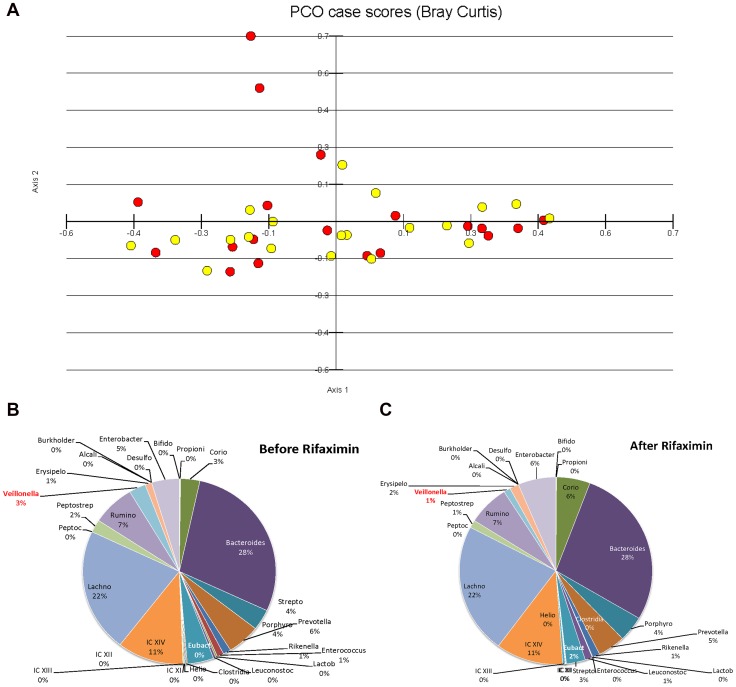
A: Principal Component Analysis of Microbiota.There was no significant change in the PCO of microbiota before and after rifaximin therapy (yellow dots are before and red dots are after rifaximin) B and C: Composition of microbiota families before (figure 2B) and after (figure 2C) rifaximin. There was a significant decrease in Veillonellaceae and increase in Eubacteriaceae abundance after rifaximin therapy (marked in red).